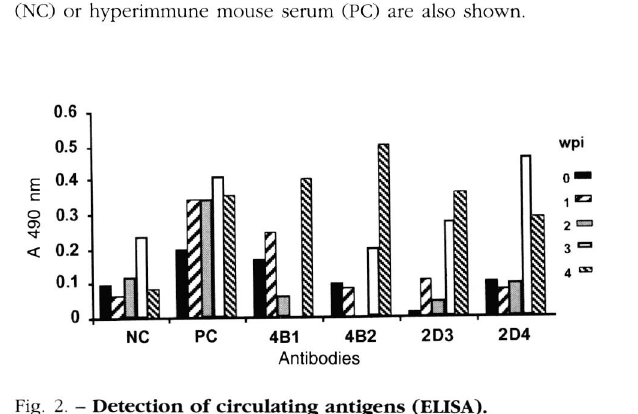
Fig. 2. - Detection of circulating antigens (ELISA). Serum samples were obtained at 0, 1, 2, 3 and 4 week post infec tion and were adsorbed to plates and incubated with the superna tant from hybridoma cultures (4B1, 4B2, 2D3 and 2D4). Non immune mouse serum (NC), as well as hyperimmune mouse serum (PC) were used as negative and positive